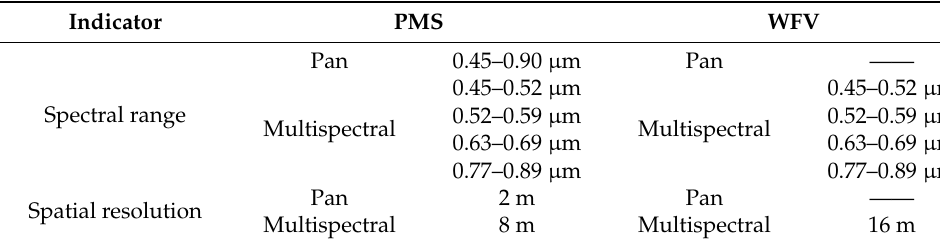
Table 1. Technical indicators of Gaofen-1 (GF-1).